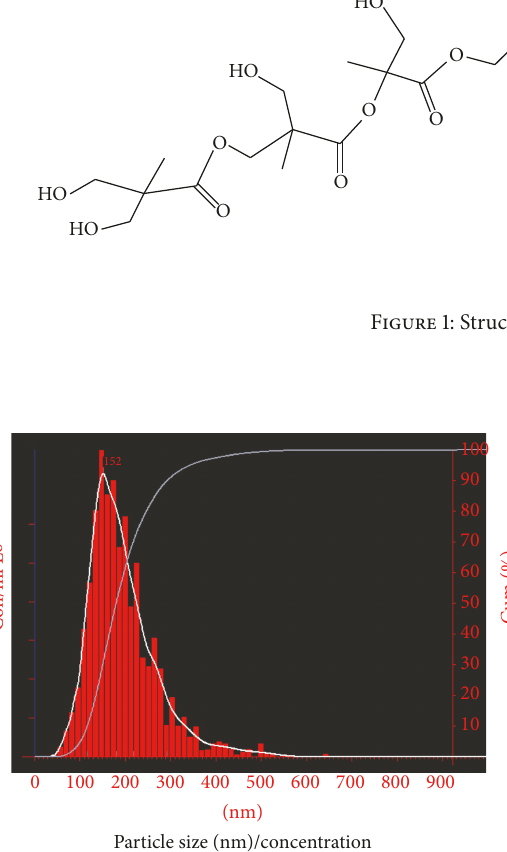
Figure 2: Concentration and size distribution from NTA measure- ments of BH20 aqueous solution.